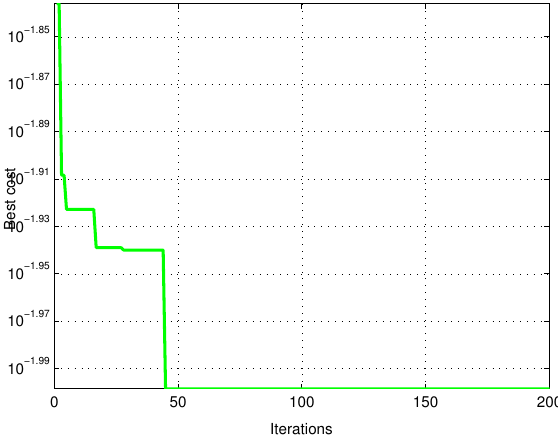
Figure 32. PSO graph converging to 200 particles and 45 iterations.